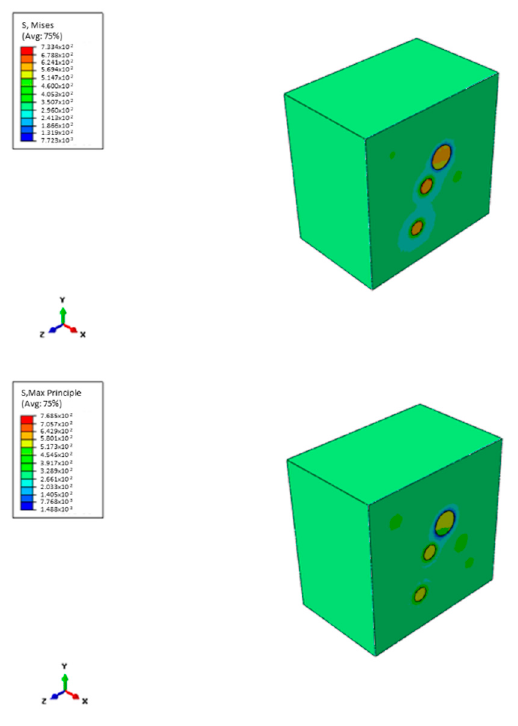
Figure 11. Finite element stress analysis of samples.